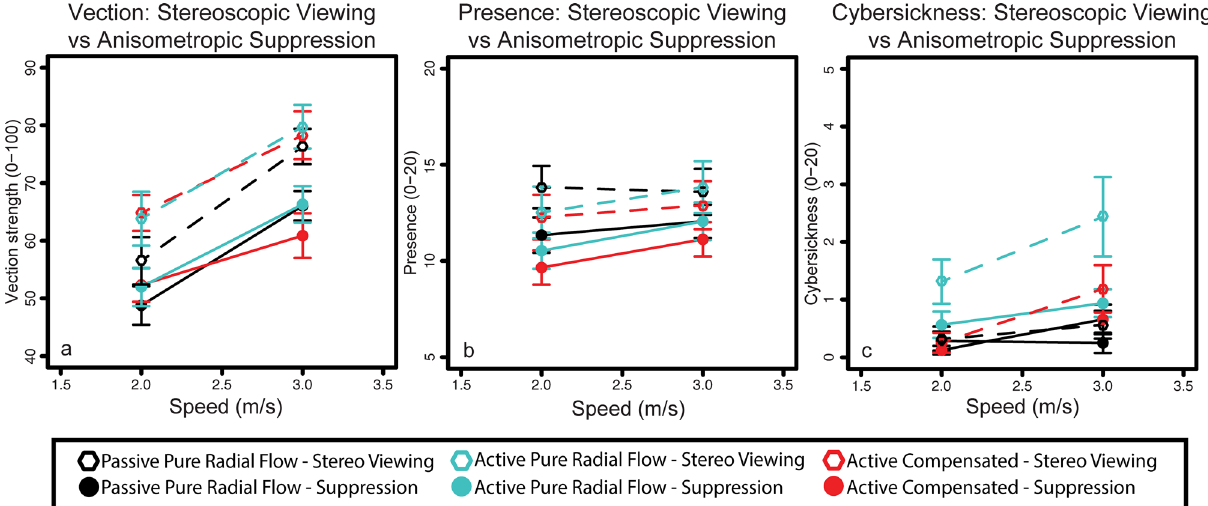
Figure 1. Mean vection strength ( a ), spatial presence ( b ) and cybersickness ( c ) scores plotted as function of simulated speed for each of the visual motion (passive radial, active radial and active compensation) and viewing conditions (stereoscopic viewing or anisometropic suppression). Open symbols represent results from stereoscopic viewing conditions and solid symbols represent results from viewing conditions following anisometropic suppression. Error bars show standard error of the mean. N = 32.